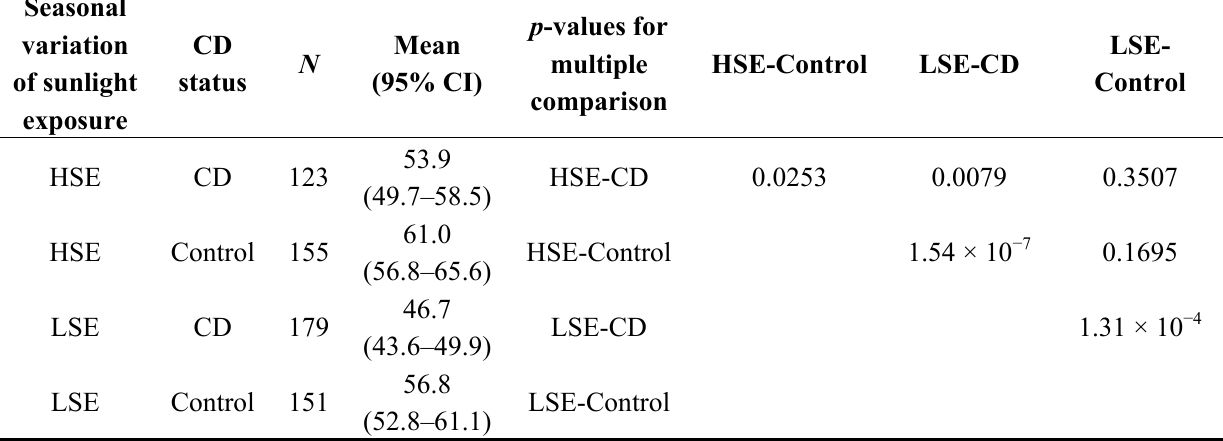
Table 2. Serum vitamin D by Crohn’s Disease status and seasonal variation of sunlight exposure.